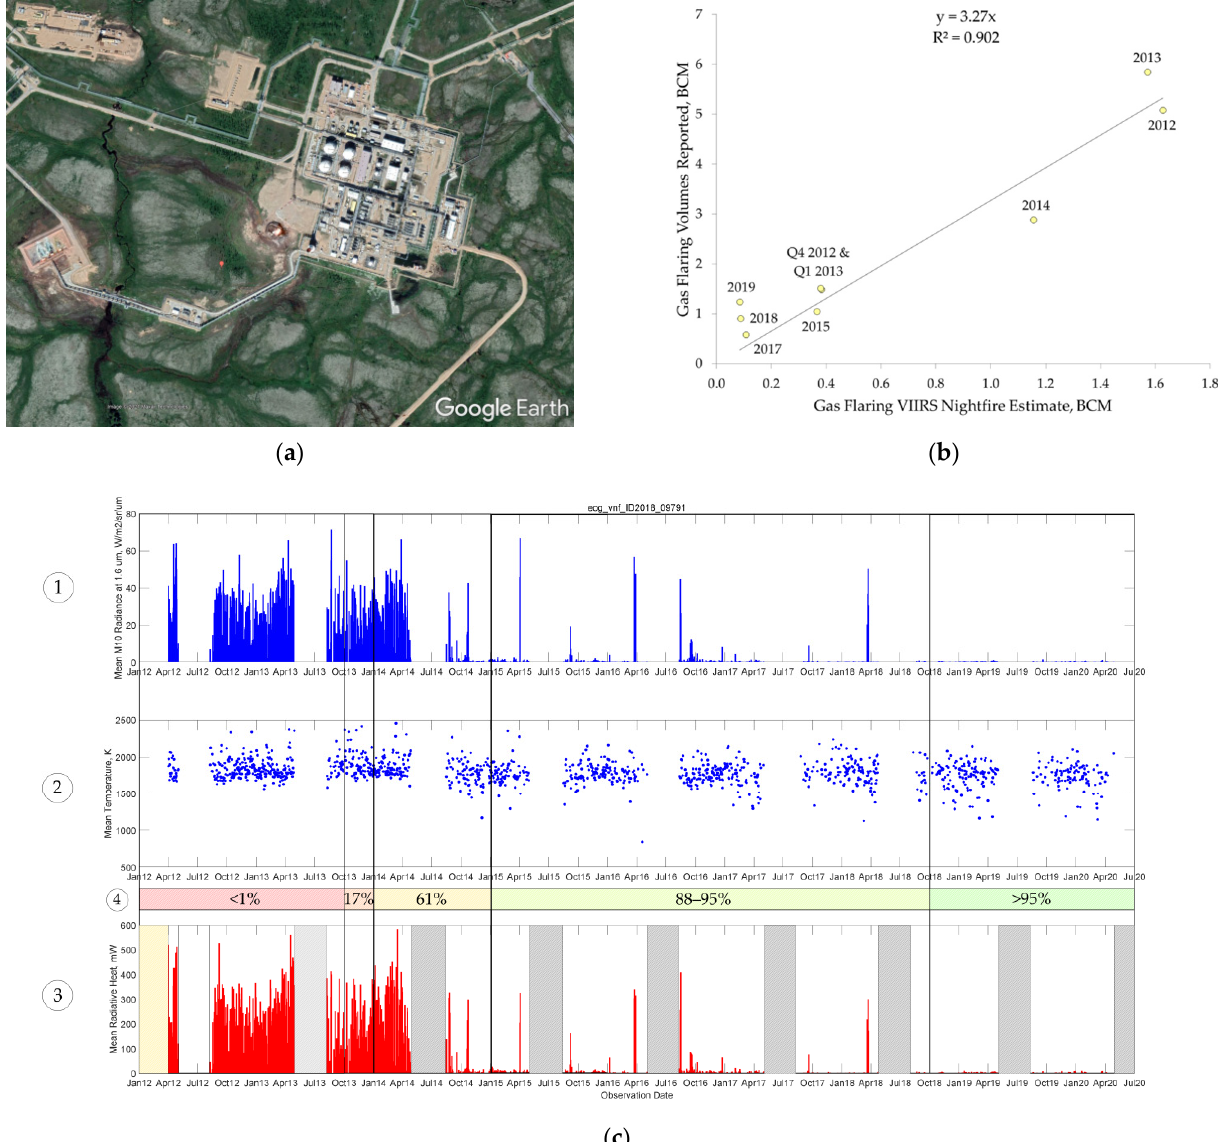
Figure 10. VIIRS Nightfire gas flaring data dashboard for the southern oil dehydration and desalting unit of the Vankor oil field in Krasnoyarsk Krai, Russian Federation (67°43 ′ N 83°30 ′ E). ( a ) High-resolution image of the oil dehydration and desalting unit available in Google Earth. Note that three ground flare stacks and one vertical flare stack in close proximity are aggregated into a single Nightfire detection. ( b ) Plot Nightfire estimates ( x -axis, BCM) with reported flaring data ( y -axis, BCM) [47,53–58]. Nightfire estimates are a sum of all detected flaring volumes within the Vankor field. Note the difference in scale for the axes. ( c ) Daily flare dashboard of the flare stack cluster at Vankor southern oil dehydration and desalting unit as shown in ( a ), containing ① spectral radiance in M10 SWIR channel of VIIRS, ② mean estimated temperature (in K), ③ mean estimated radiant heat RH (in MW), and ④ reported APG utilization rate of the field.